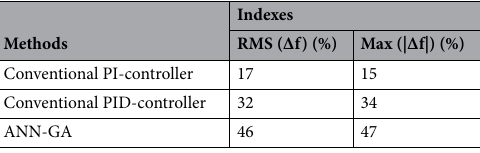
Table 4. Percentage improvement of RMS (Δf) and max (|Δf|)